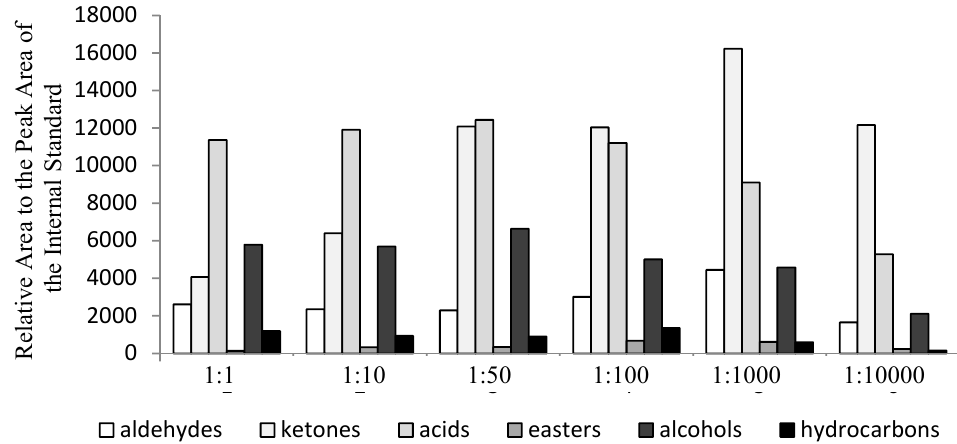
Figure 2. The categories and relative peak areas compared to those of the internal standards for the volatiles in milk fermented with different proportions of L. delbrueckii subsp. bulgaricus IMAU20401 and S. thermophilus ND03.